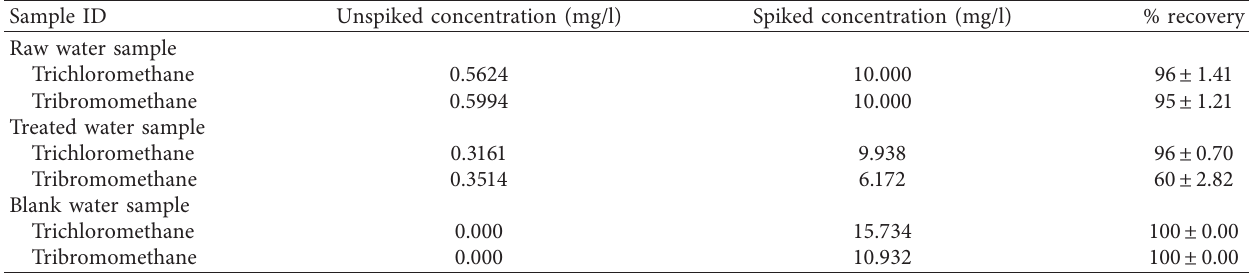
Table 6: Mean percentage (%) recoveries of trichloromethane and tribromomethane from raw, treated and blank water samples after extraction with Dichloromethane.